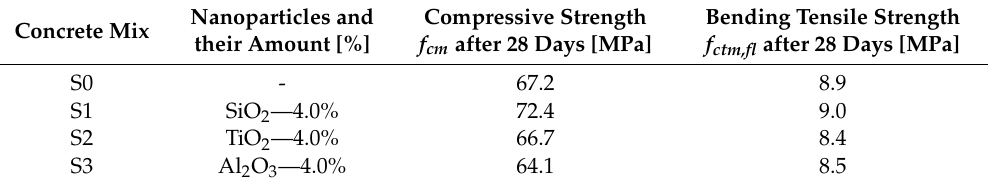
Table 5. Mechanical properties of self-compacting concrete mixes (based on [22]).